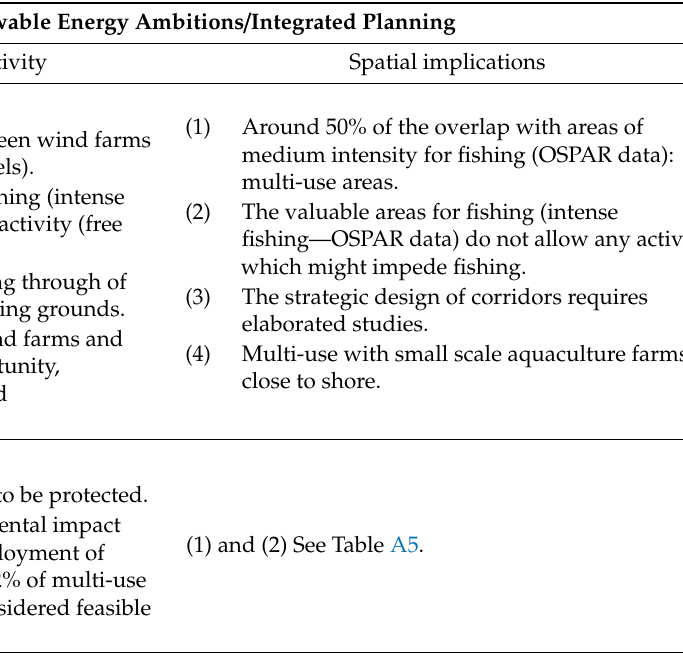
Table 8. Scenario B: Low renewable energy ambitions / integrated